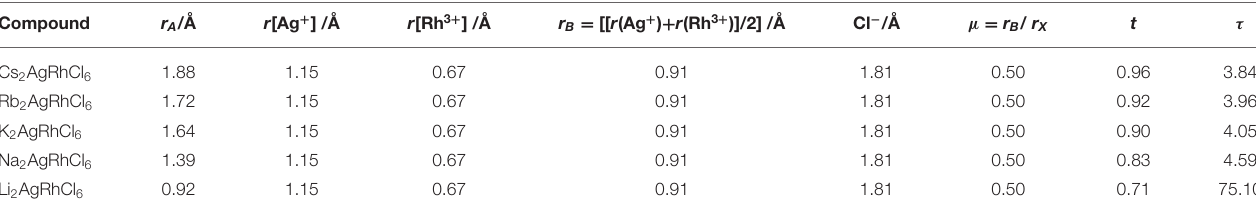
TABLE 3 | Shannon’s ionic radii ( r ) of ions, octahedral factor ( µ ), Goldschmidt tolerance factor ( t ), and new tolerance factor ( τ ) for A 2 AgRhCl 6 (A